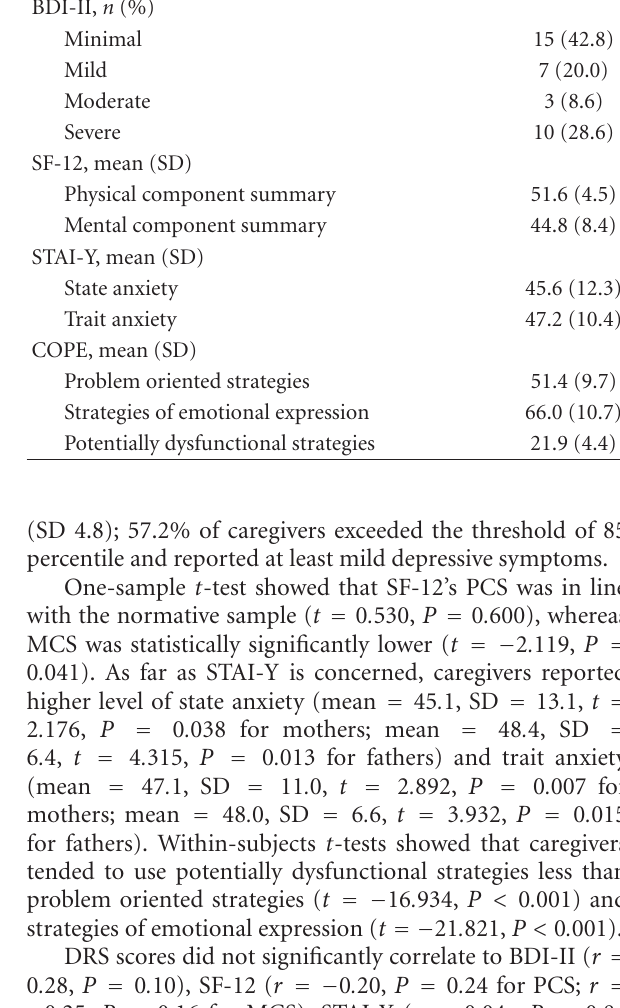
Table 3: Socio-demographic characteristics of caregivers of chil- dren with DOCs.